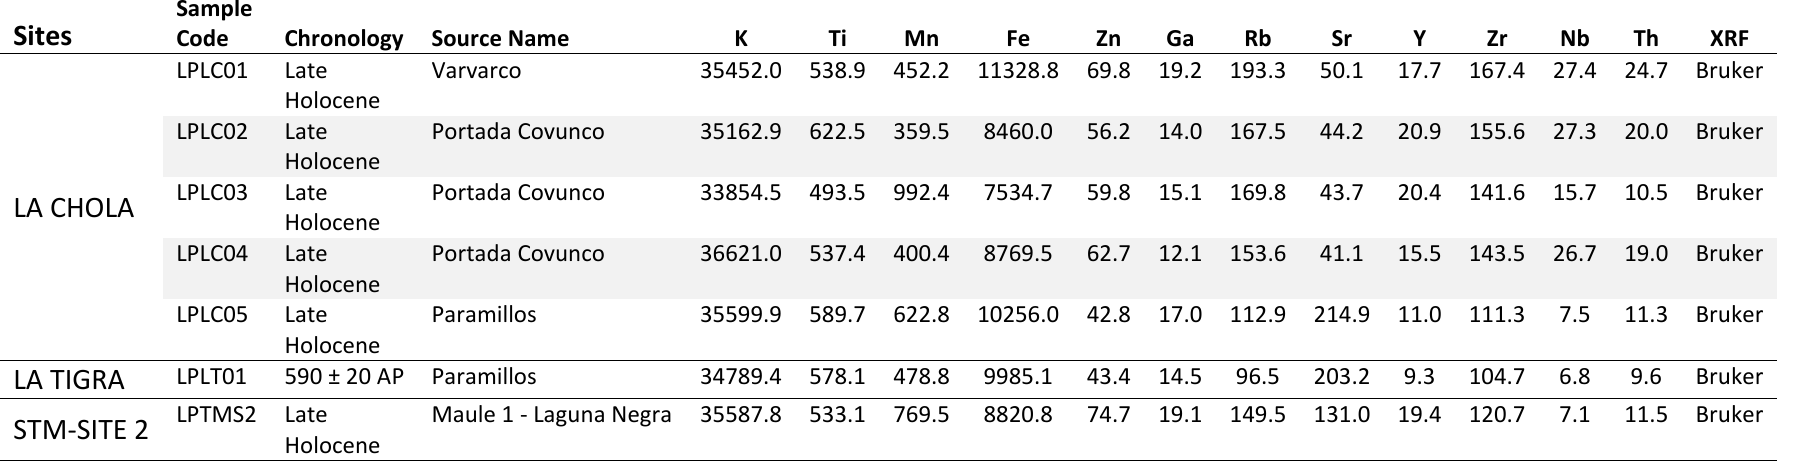
Table 3. Results obtained from XRF (Bruker III-V).